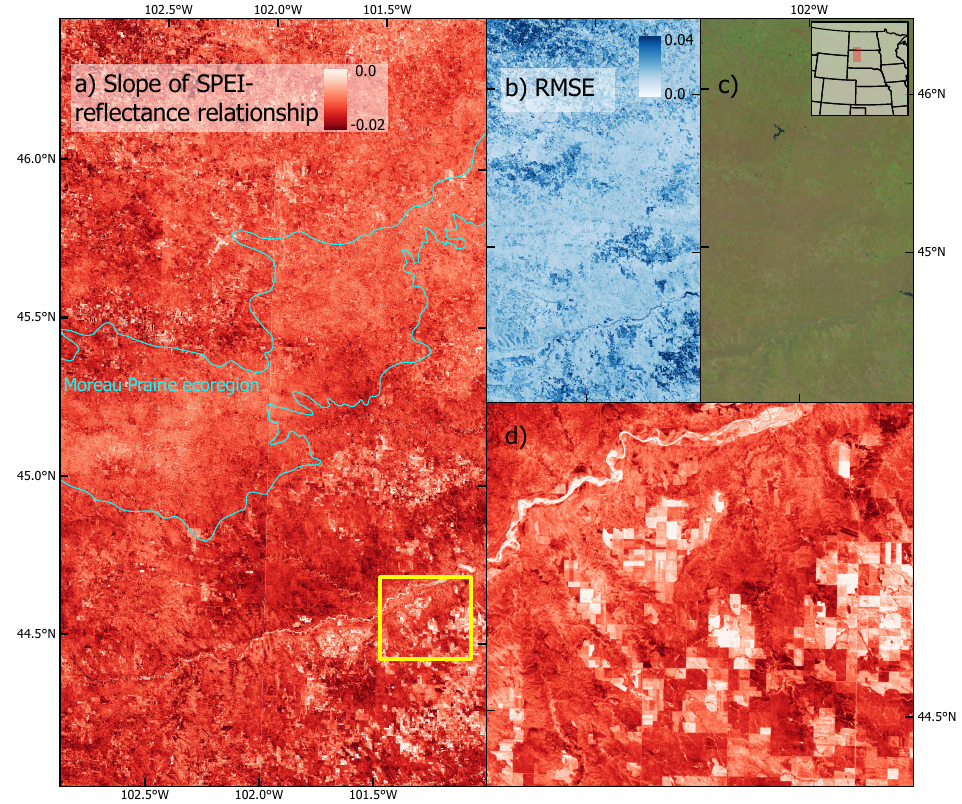
Figure 11. Per-pixel images of the effective moisture-reflectance relationship. ( a ) Slope of SPEI-reflectance regression for each pixel in the study area; darker red is a steeper (more negative) slope, while white is a near-zero slope. The line down the middle of the image is due to re-projection across the UTM boundary. ( b ) RMSE of SPEI reflectance regression across the study area; darker blue is a larger RMSE. ( c ) Natural color Landsat mosaic of the study area. ( d ) Zoom in view of the yellow rectangle in Panel ( a